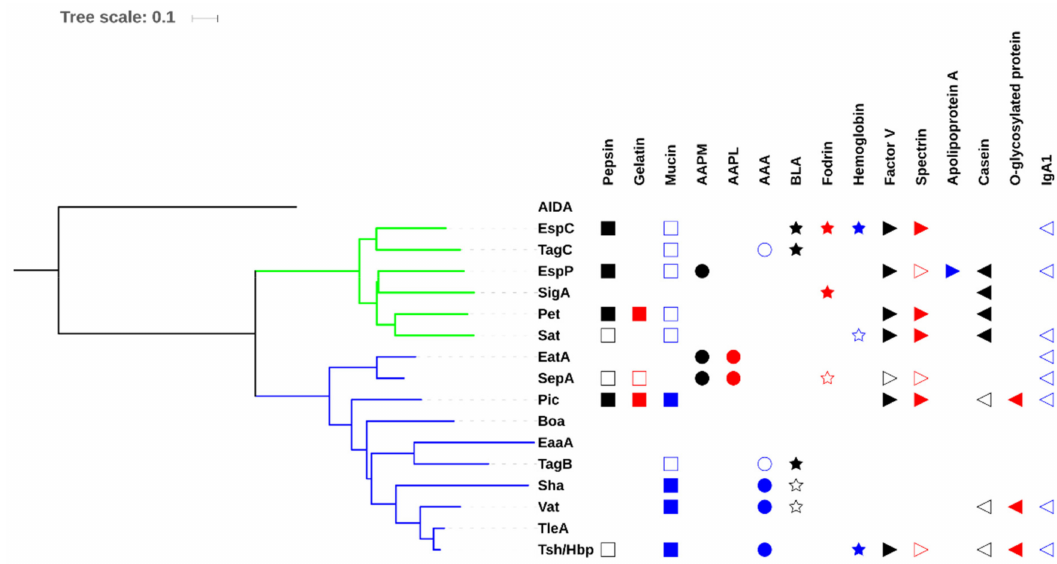
Figure 4. Evolutionary relationships of SPATEs based on passenger domain sequences and presentation of known protease substrates. The evolutionary history of passenger domains of characterized SPATEs was inferred using the neighbor-joining method [48]. The tree is drawn to scale, with branch lengths in thesameunitsasthoseoftheevolutionarydistancesusedtoinferthephylogenetictree. Theevolutionary distances were computed using the JTT matrix-based method [49] and are in the units of the number of amino acid substitutions per site. The analysis involved 17 protein sequences. All positions containing gaps and missing data were eliminated. Evolutionary analyses were conducted in MEGA6 [50]. Multiple sequence alignment was performed by Clustal W and the tree was constructed using the Mega6 software with PhyML / bootstrapping and iTOL [51]. Cluster of cytotoxic SPATEs (class 1) are in green branches while immunomodulator SPATEs (class 2) are in blue branches. SPATE protein sequences are available in NCBI database as follows: EspC, GenBank Accession No. AAC44731; EspP, NP_052685; SigA, AF200692; Pet, SJK83553; Sat, AAG30168; EatA, CAI79539, SepA, Z48219; Sha, MH899684; Pic, ALT57188; Boa, AAW66606; TagB and TagC, MH899681; EaaA, AAF63237; Vat, AY151282; TleA, KF494347; Tsh / Hbp, AF218073; AIDA, ABS20376; AAPM: MeOSuc-Ala-Ala-Pro-Met-pNA, AAPL: 4-nitroanilide. The cleaved substrates, substrates that were negative for cleavage, and those untested substratesarerepresentedbyfilledsymbol, unfilledsymbolandnosymbolrespectively. Thiscomparison shows that some of the activities are phylogenetically